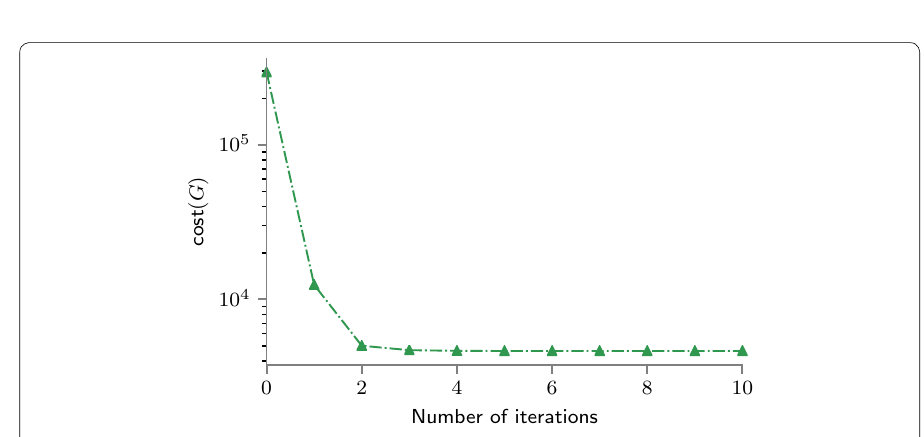
Fig. 9 Graph cost function with coarsening